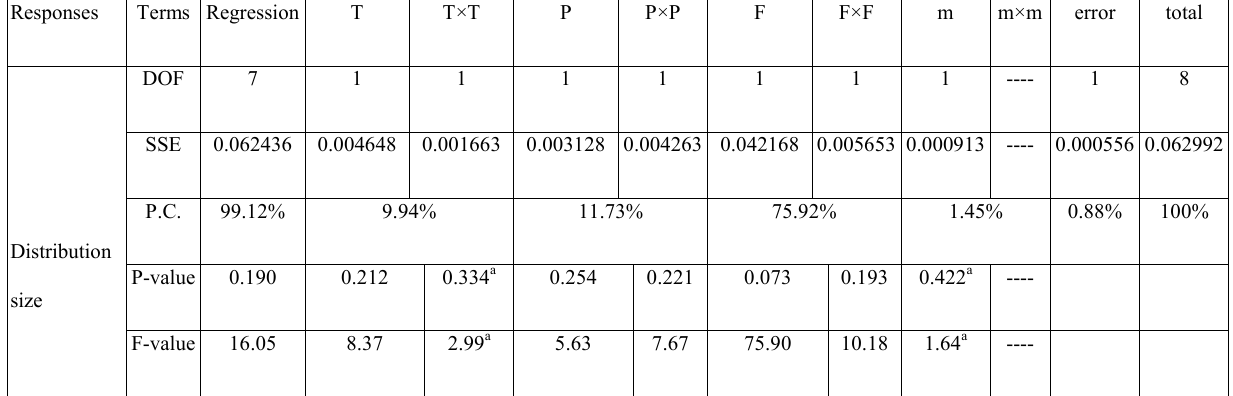
ANOVA of granule size distribution (with pooling